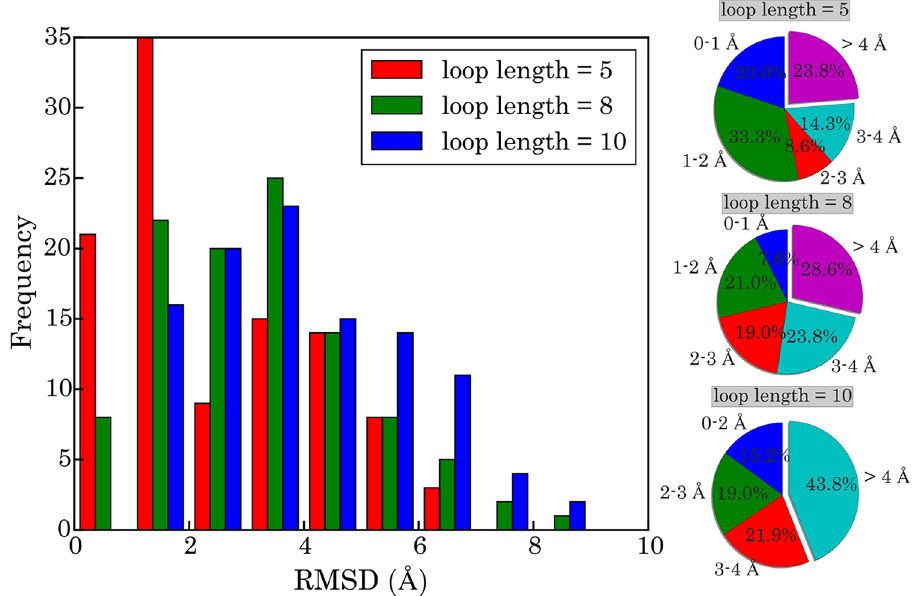
Fig 6. Distribution of RMSDs of 105 fragments in 1FFK of different length (5-, 8-, and 10-nt). For each fragment, the central structure of the largest cluster was taken as the predicted structure. The RMSDs are calculated based on heavy atoms after optimal superposition of the predicted structures with the experimental ones. The pie charts show the proportions of RMSDs within certain ranges indicated by the labels; from top down they correspond to the fragments of length 5, 8, and 10,